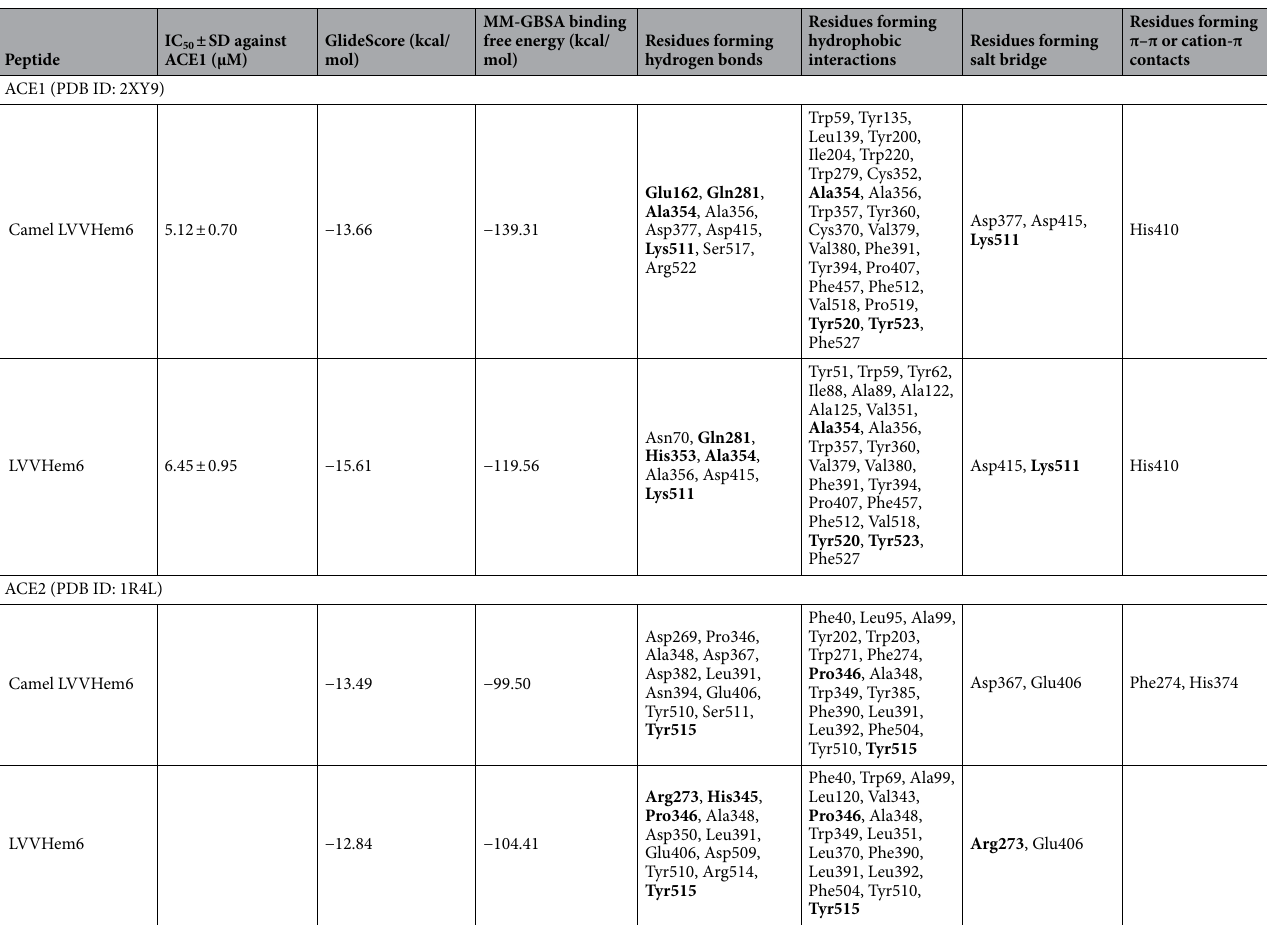
Table 4. Interactions of the best binding pose of the top two peptides with ACE1 (PDB ID: 2XY9) and ACE2 (PDB 1R4L). The residues in bold represent the active